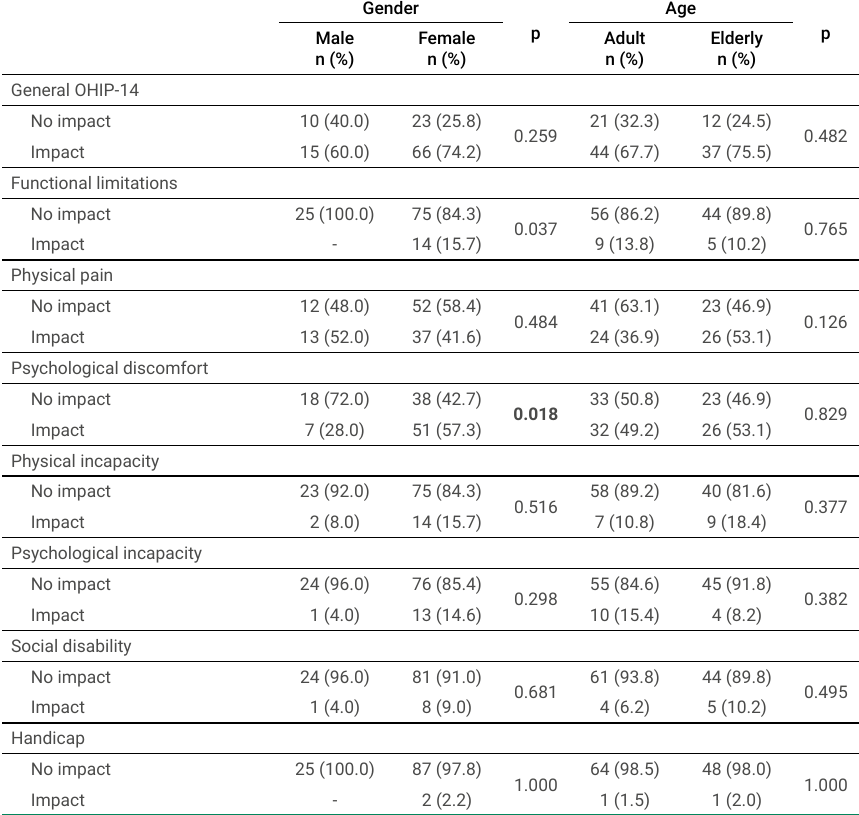
Table 1. Distribution of oral health impact on QoL, as evaluated by the OHIP-14, and parameters according to gender and age.